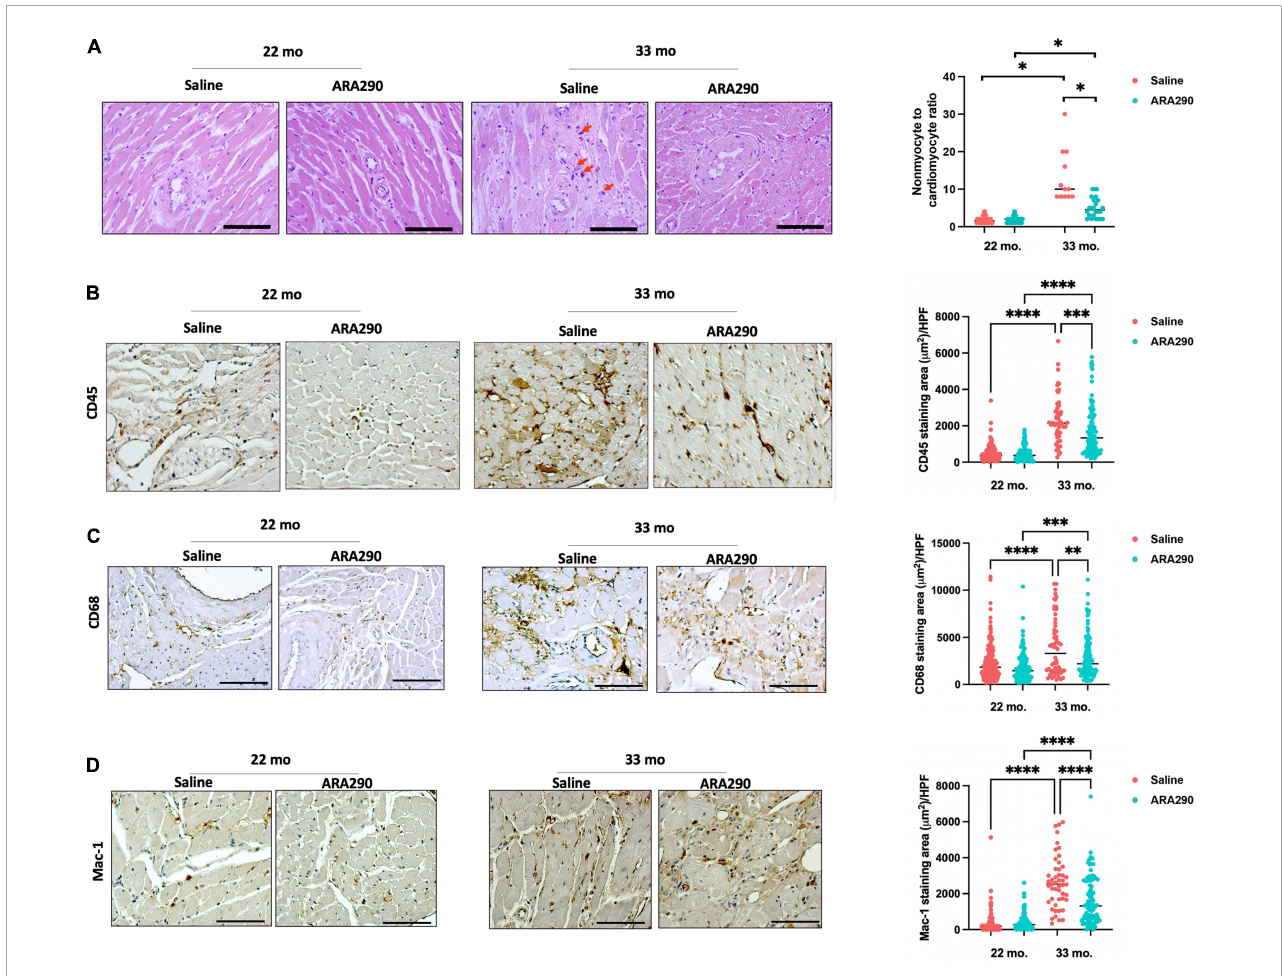
FIGURE5 Histomorphometric analysis at 22 (Saline n = 10; ARA290 n = 11) and 33 (Saline n = 4; ARA290 n = 8) months of age. Ratio of cardiac non-myocytes to myocytes within the myocardium and interstitial giant cells (red arrow) at 22 and 33 months of age (A) . Staining of myocardium with CD45, a pan-leukocyte marker (B) , CD68, a marker of inflammation associated with monocytes/macrophages (C) , and Mac-1, an integrin that facilitates recruitment of leukocytes (D) at 22 and 33 months of age. Statistically significant interactions between treatment groups are shown ( ∗ P < 0.05, ∗∗ P < 0.01, ∗∗∗ P < 0.001, ∗∗∗∗ P <